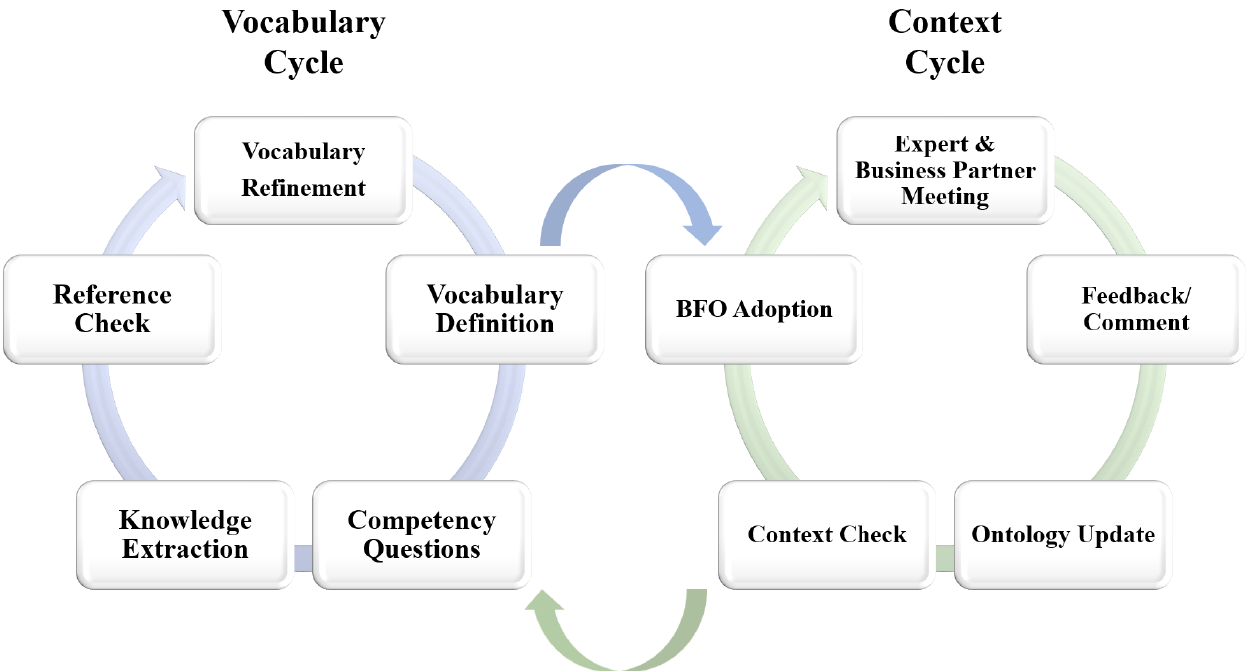
Figure 1. Two-cycle methodology.